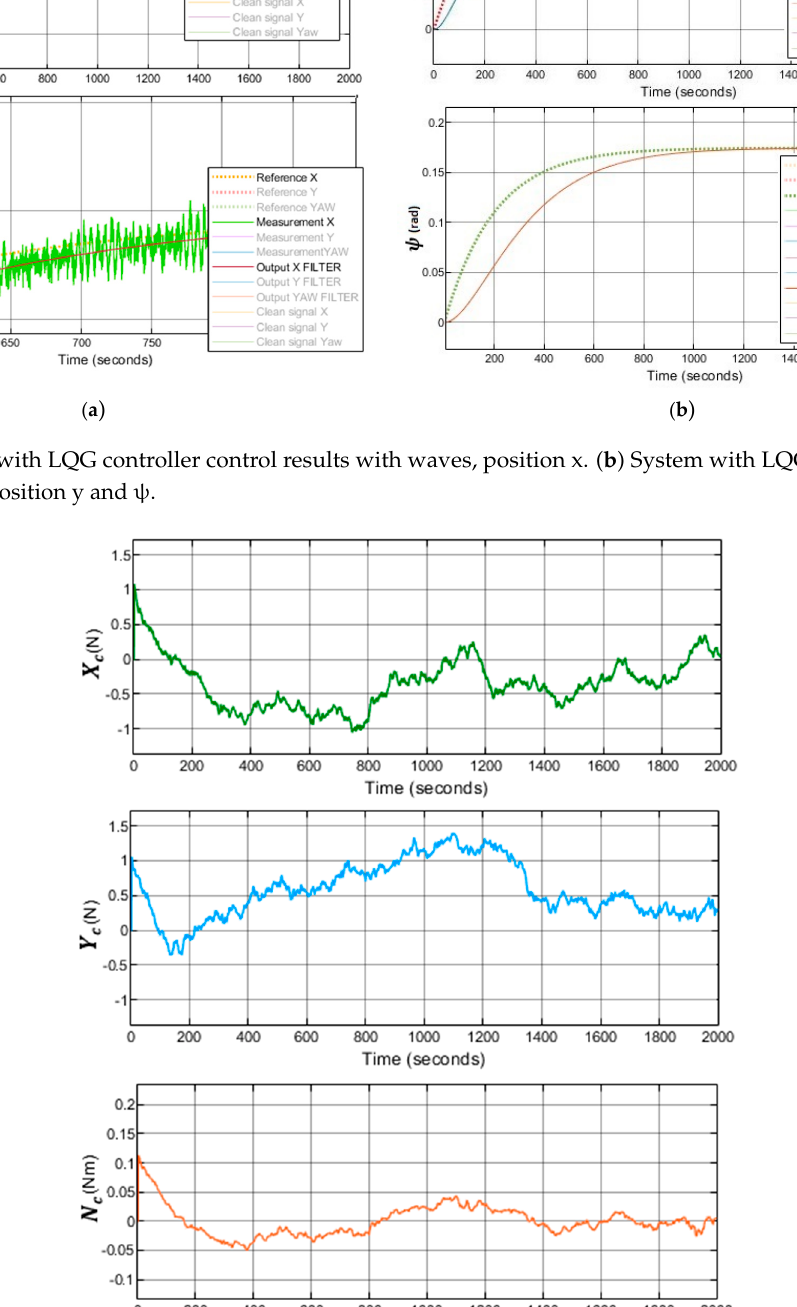
Figure 8. System with LQG controller control results with waves. Control signals calculated by the double-loop controller.